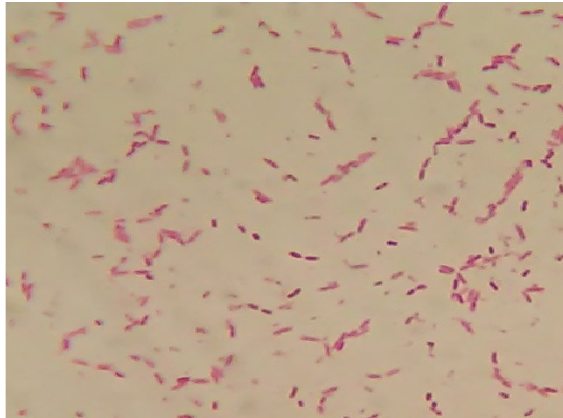
Fig.3 Optical microscope image of rod-shaped Bacillus